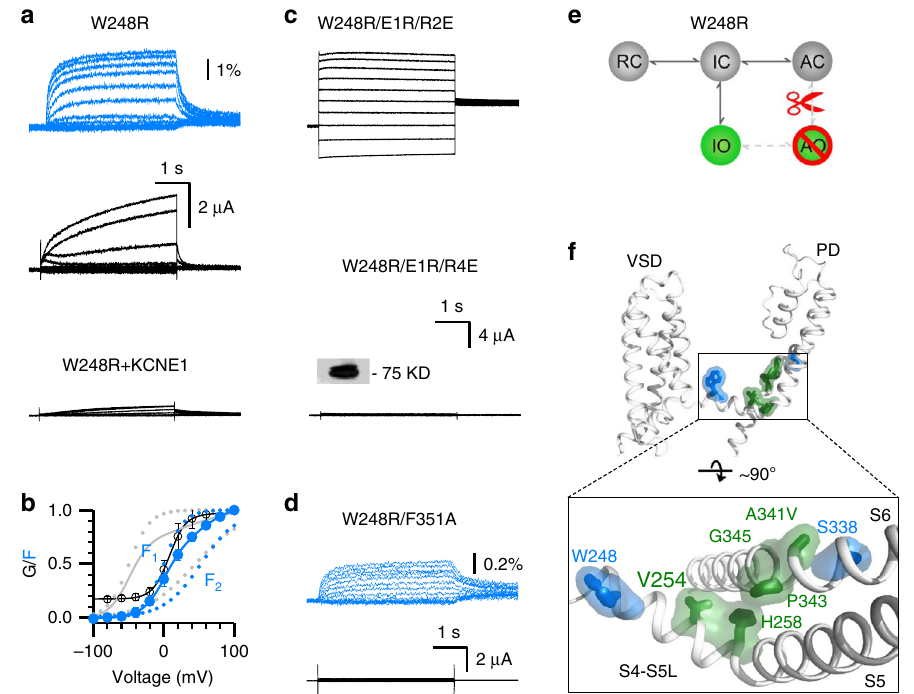
Fig. 2 LQTS mutation W248R speci fi cally eliminates the E – M coupling when the VSDs adopt the activated conformation. a , b VCF recordings of W248R in K V 7.1*. W248R + KCNE1 currents are shown at the same scale. The F – V relationships of K V 7.1 and W248R are shown in gray and blue, respectively. n ≥ 3. All averaged data are shown in mean±SEM. c Representative currents of W248R/E1R/R2E and W248R/E1R/R4E activated from − 120 mV to 60 mV with 20 mV increments. Same scale for both currents. The inset shows western blot data for membrane expression of W248R/E1R/ R4E. d VCF recordings of W248R/F351A. e Cartoon scheme illustrating that W248R speci fi cally disrupts the AO E – M coupling. f Mapping the key residues at the S4-S5L/S6c interface (green, V254, H258, A341, P343, and G345) in Fig. 1, and W248 and S338 (blue) onto the K V 7.1 cryoEM structure (PDB: 5VMS) 2 . Source data are provided as a Source Data fi